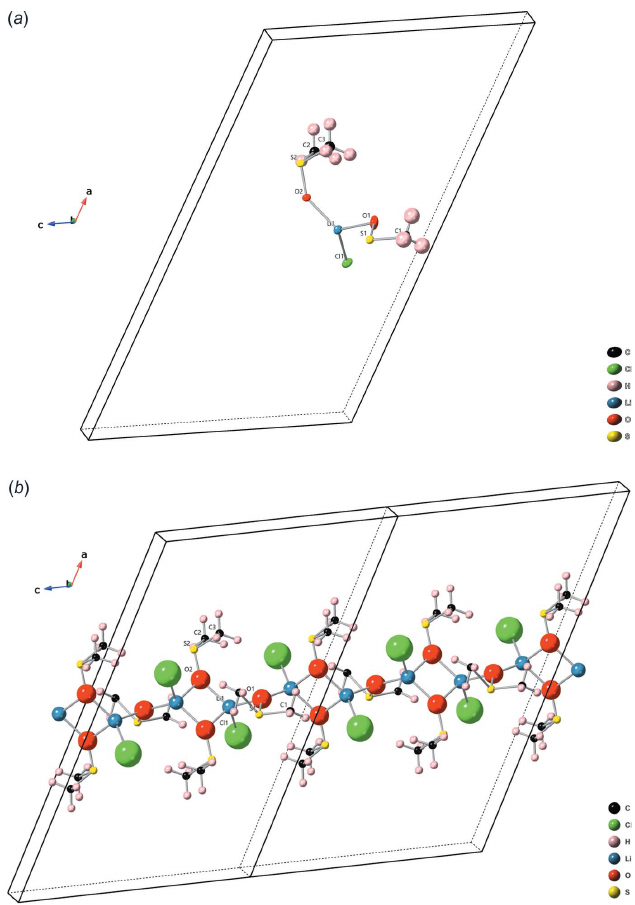
Figure 1 Monoclinic structure: asymmetric unit ( a ) and polymeric chain view ( b ). The repeating unit of the polymer has four LiCl and six DMSO. The sulfur atom of the DMSO is disordered across two positions. Only one position is shown.